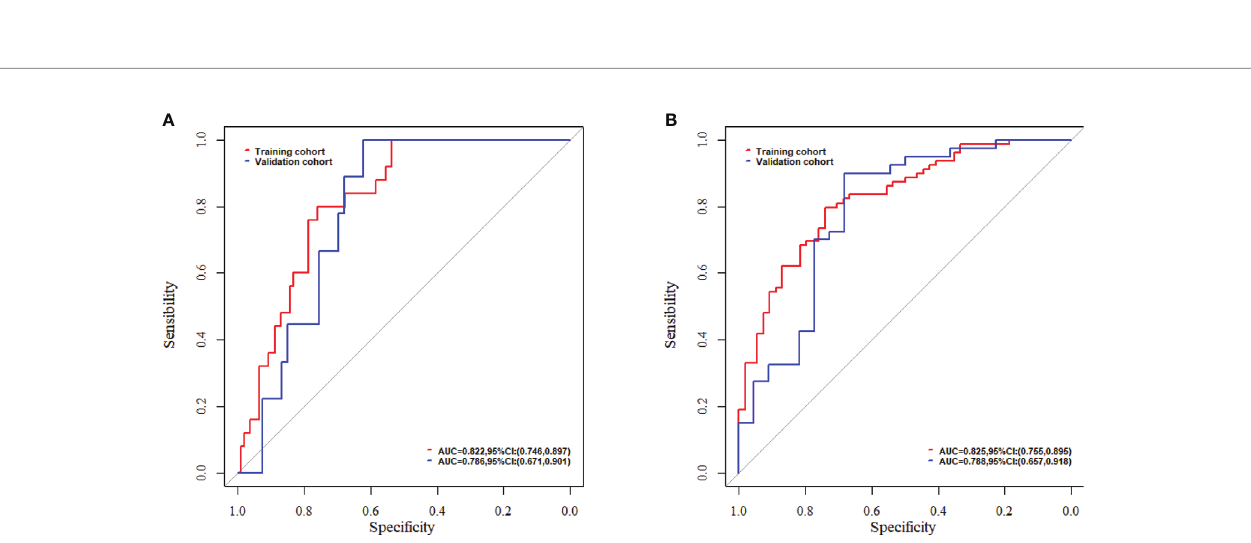
FIGURE 6 | The evaluation of nomogram with receiver operating characteristic curves for (A) short-term survival prediction model; (B) long-term survival prediction